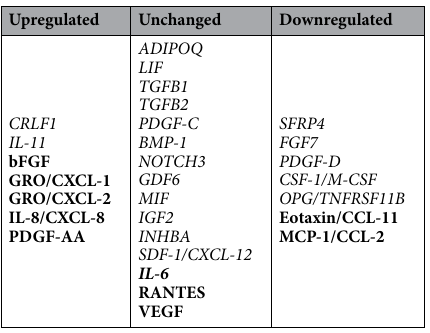
Table 2. Major soluble mediators differentially present in STS-CM compare to UNT-CM. Proteins detected by LC–MS (italics), Bioplex experiment (bold) or both